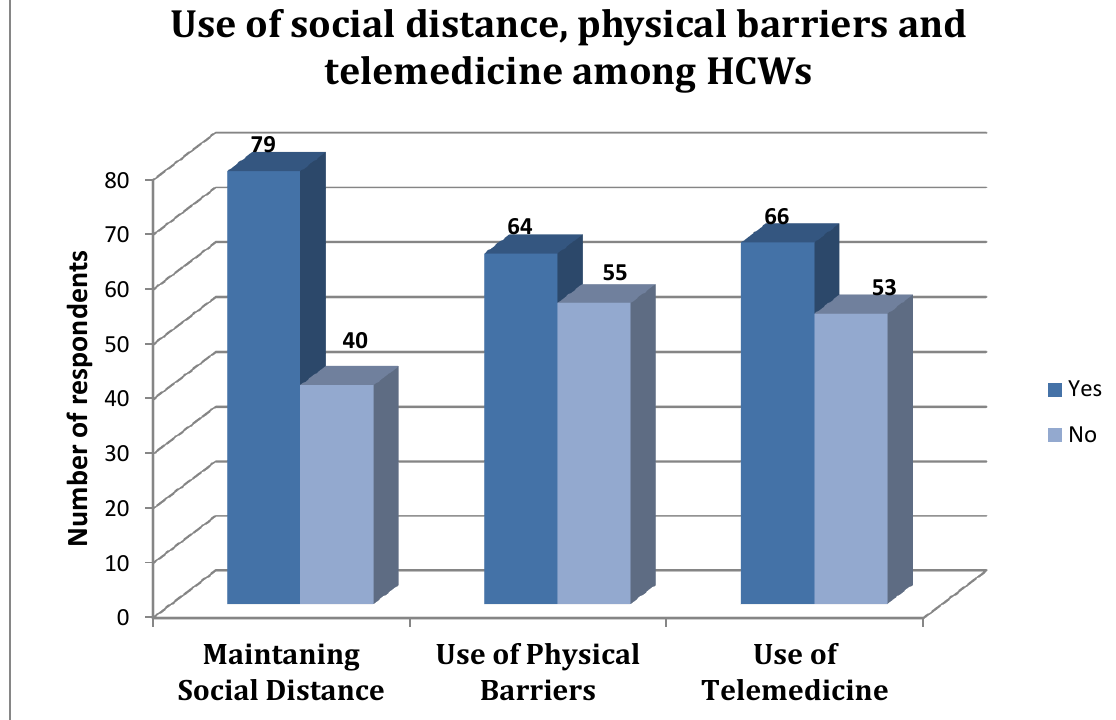
Figure 4. Bar chart showing other protective practices against